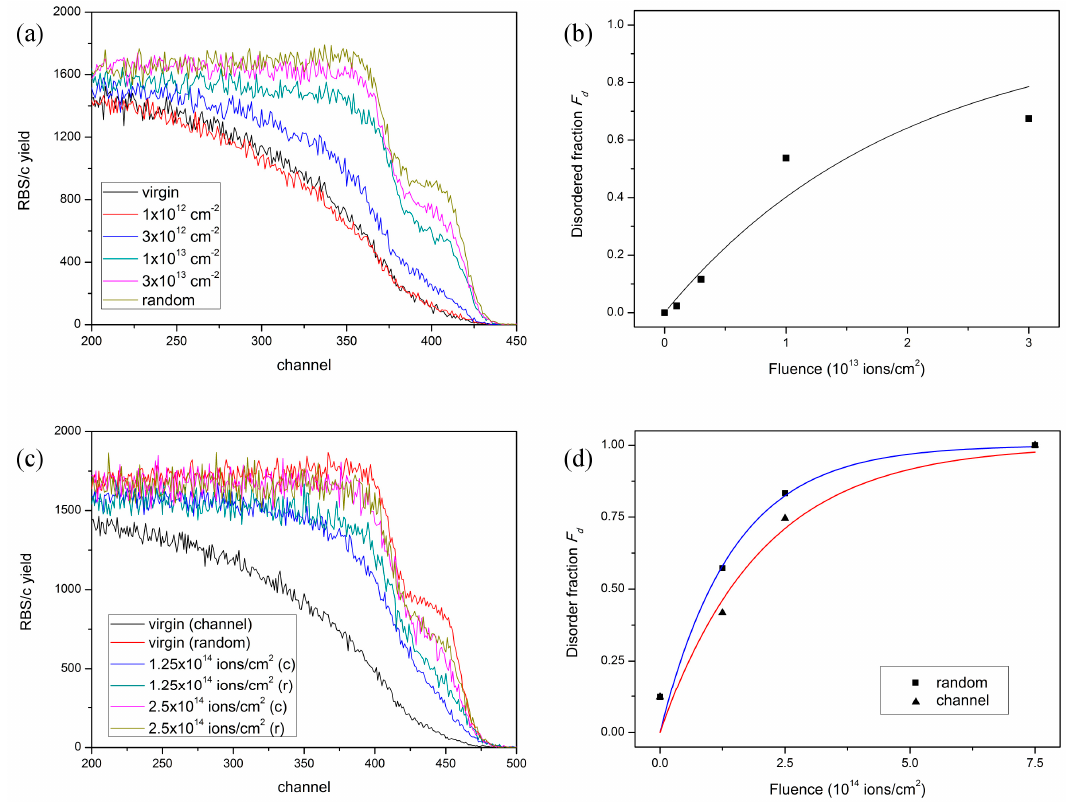
Figure 2. ( a ) RBS/c spectra from quartz SiO 2 irradiated with different fluences of 5 MeV Si ions; ( b ) Analysis of RBS/c data yields ion track radius R = 1.3 ± 0.15 nm; ( c ) RBS/c spectra from quartz SiO 2 irradiated with different fluences of 4 MeV C ions, both in channeling and random directions; ( d ) Analysis of RBS/c data yields damage cross sections of σ R = 0.7 ± 0.1 nm 2 (blue line) and σ C = 0.5 ± 0.1 nm 2 (red line) for the random and channeling irradiations, respectively.